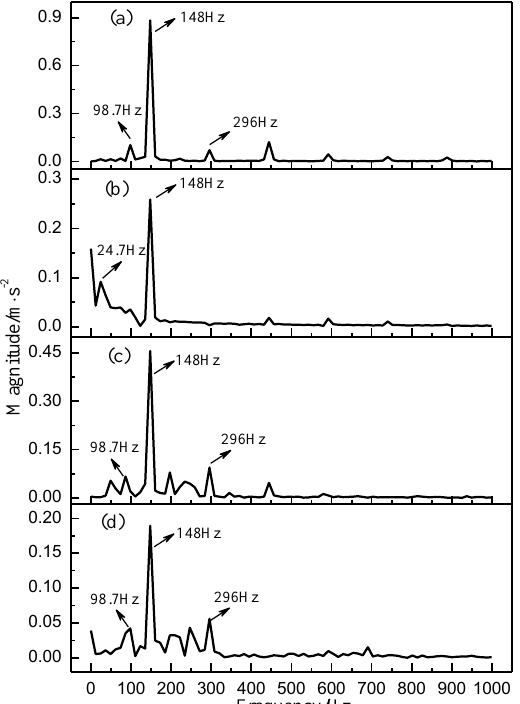
Figure 12. Comparisons of the frequency domains of the vibration acceleration under Q des : ( a ) Calculated values in X direction; ( b ) Calculated values in Y direction; ( c ) Test values in X direction; ( d ) Test values in Y direction.